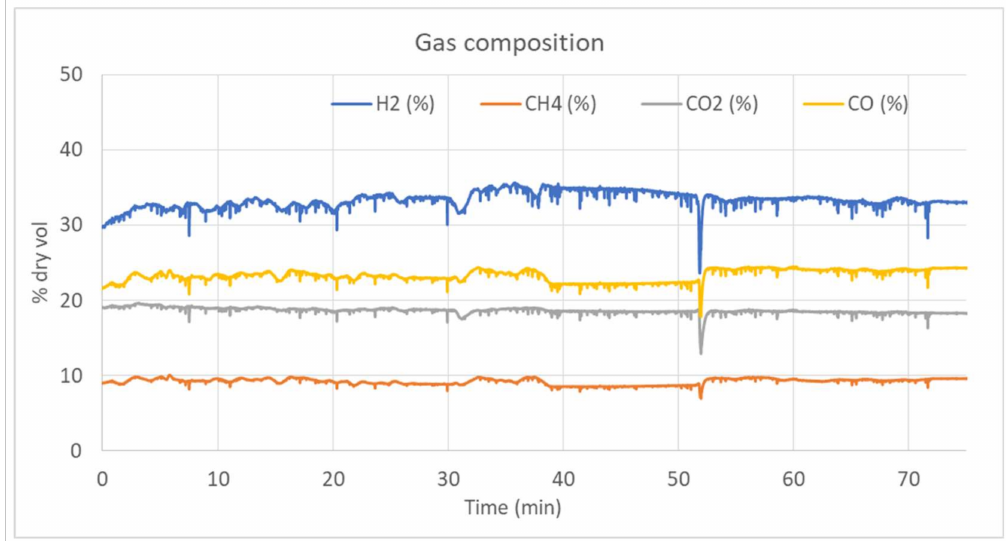
Figure 6. Raw fuel gas composition measured online during gasification test